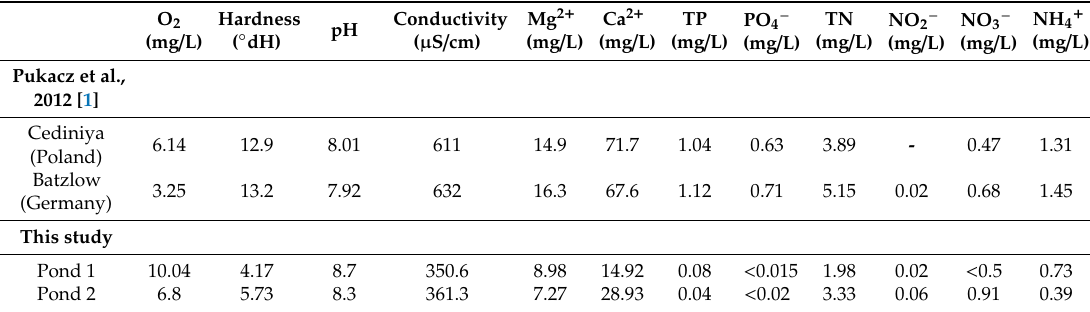
Table 3. Summed available data on the ecology of C. baueri according to Pukacz et al. [1], comparatively with the data obtained in this study (mean values